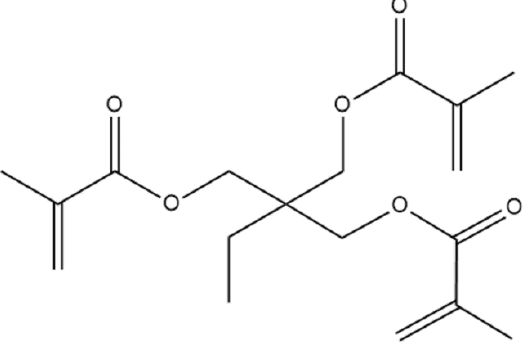
Figure 1. Chemical structure of trimethylolpropane trimethacrylate (Trim).